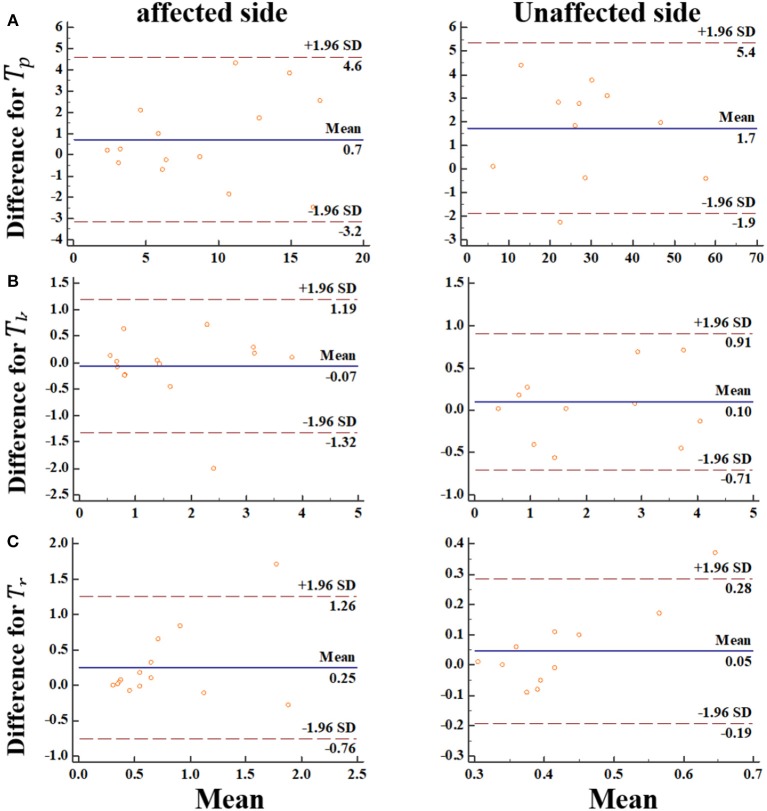
The Bland-Altman plot for the MIVC features, longitudinal axes indicates the mean of two measurements, transverse axes indicates the difference of the two measurements.(A) Peak torque TP;
(B) Keep time Tk;
(C) rise time Tr.